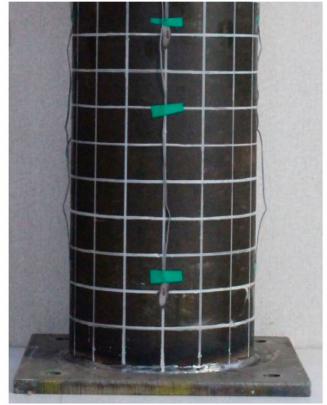
Figure 7. Drawn grid of 5 cm